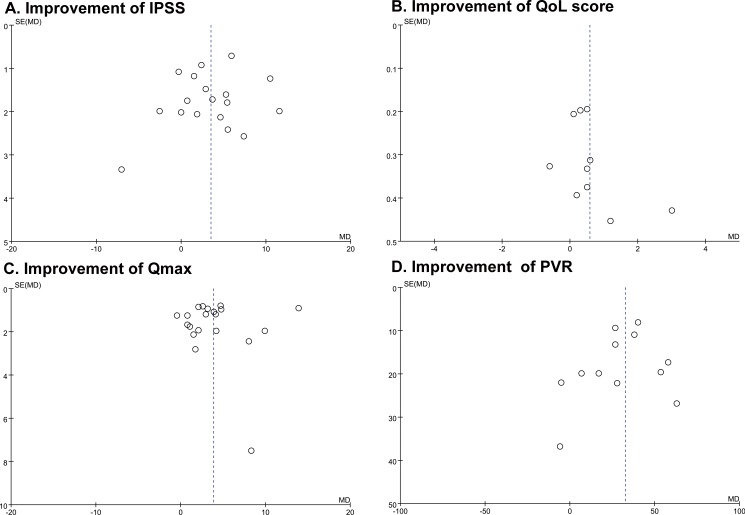
Funnel graphs of the assessment of potential publication bias in studies comparing improvement of outcome parameters after transurethral surgery with or without bladder outlet obstruction (BOO).(A) Improvement of International Prostate Symptom Score (IPSS), (B) Improvement of quality of life score (QoL), (C) Improvement of maximal flow rate on uroflowmetry (Qmax), (D) Improvement of post-void residual volume (PVR).